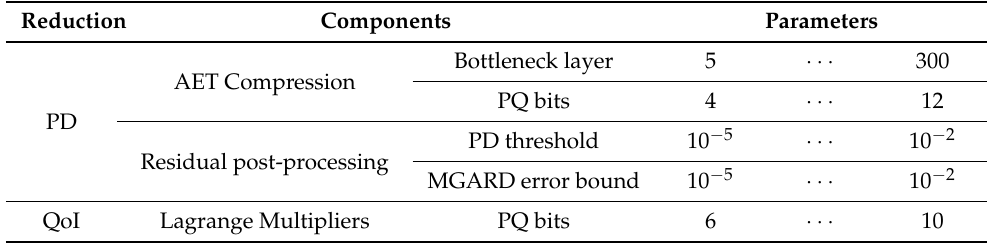
Table 2. Configuration space of our